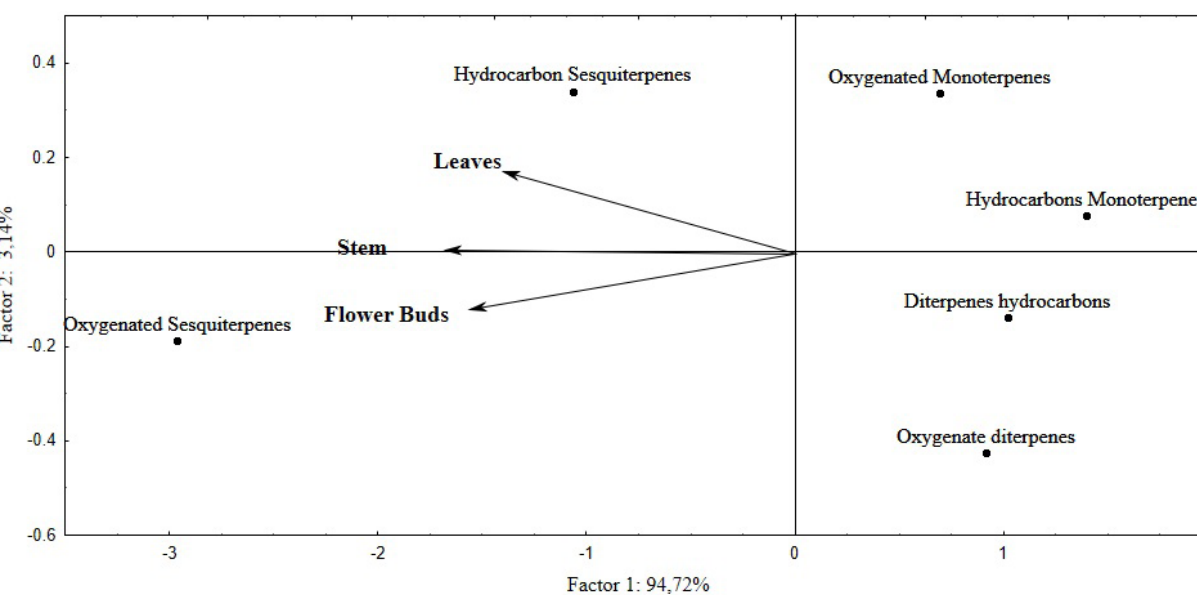
FIGURE 1 - Biplot of principal component analysis scores and loadings for the gas chromatography and mass spectrometry representing the projection of chemical classes of Tetradenia riparia leaves, flower buds and, stem essential oil. The projection of chemical compounds (Figure 2) showed the presence of fenchone (11.57%) and 6-7-dehydro- roileanone (5.80%) in the leaves; 14-hydroxy-9-epi-caryophyllene (15.38%) and α-cadinol (13.69%) in the flower buds;